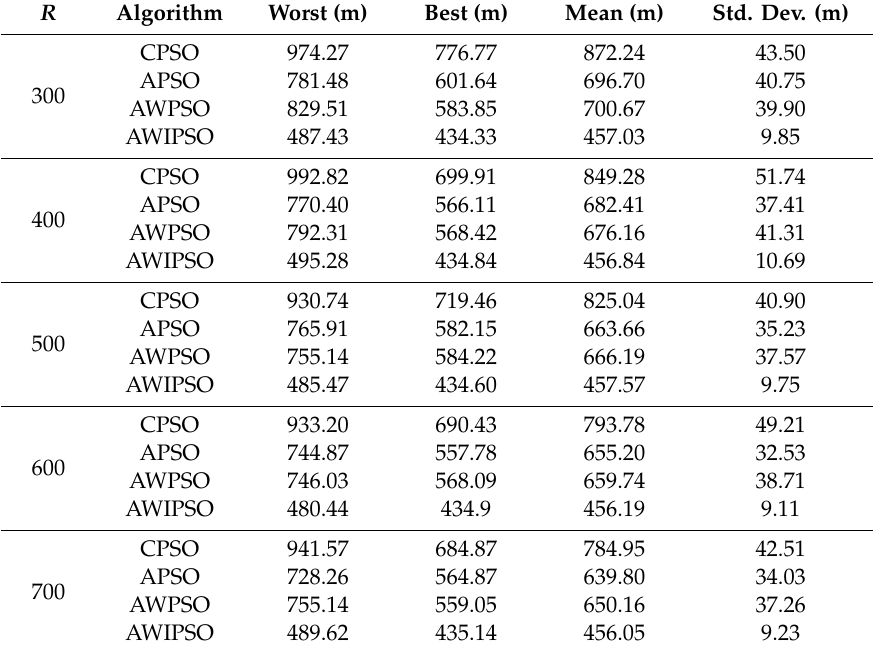
Table 3. Statistical results of optimal path distance in 100 runs with five swarm